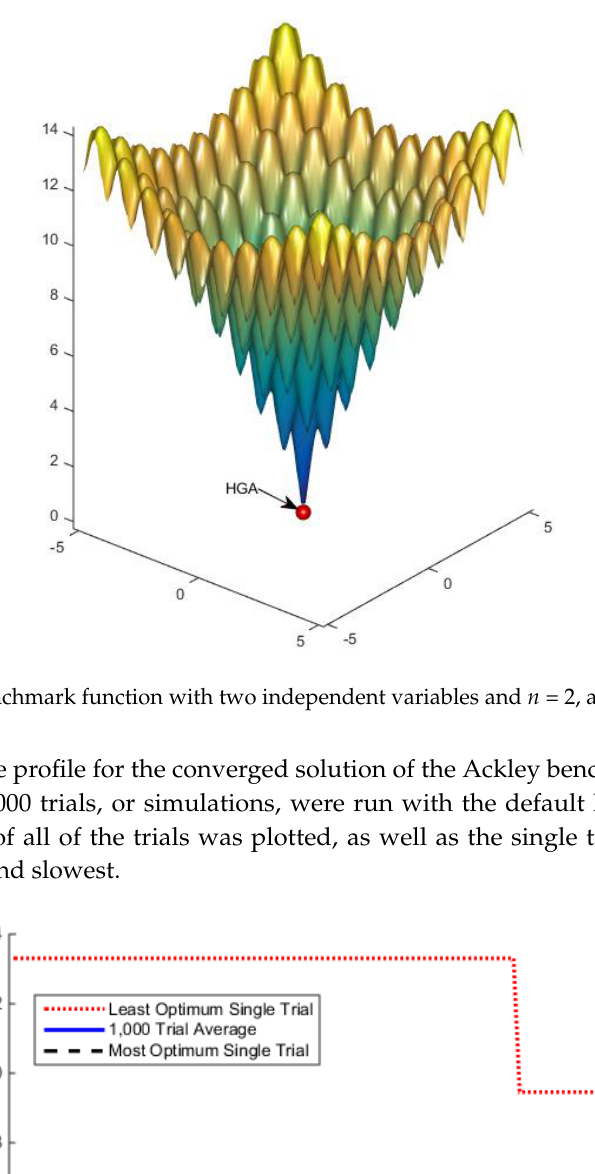
Figure 3. Ackley benchmark profile for 1000 trials with two independent variables and n = 2, a = 20, b = 0.2, c = 2π. Table 6. Results for the Ackley benchmark case study.